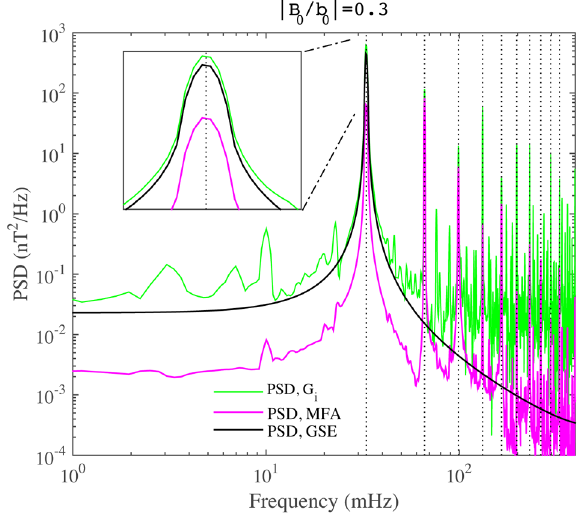
(green) and B (ma- i MFA = 11 (unstable rotation procedure, see text w is also showed (black); the fundamen- GSE